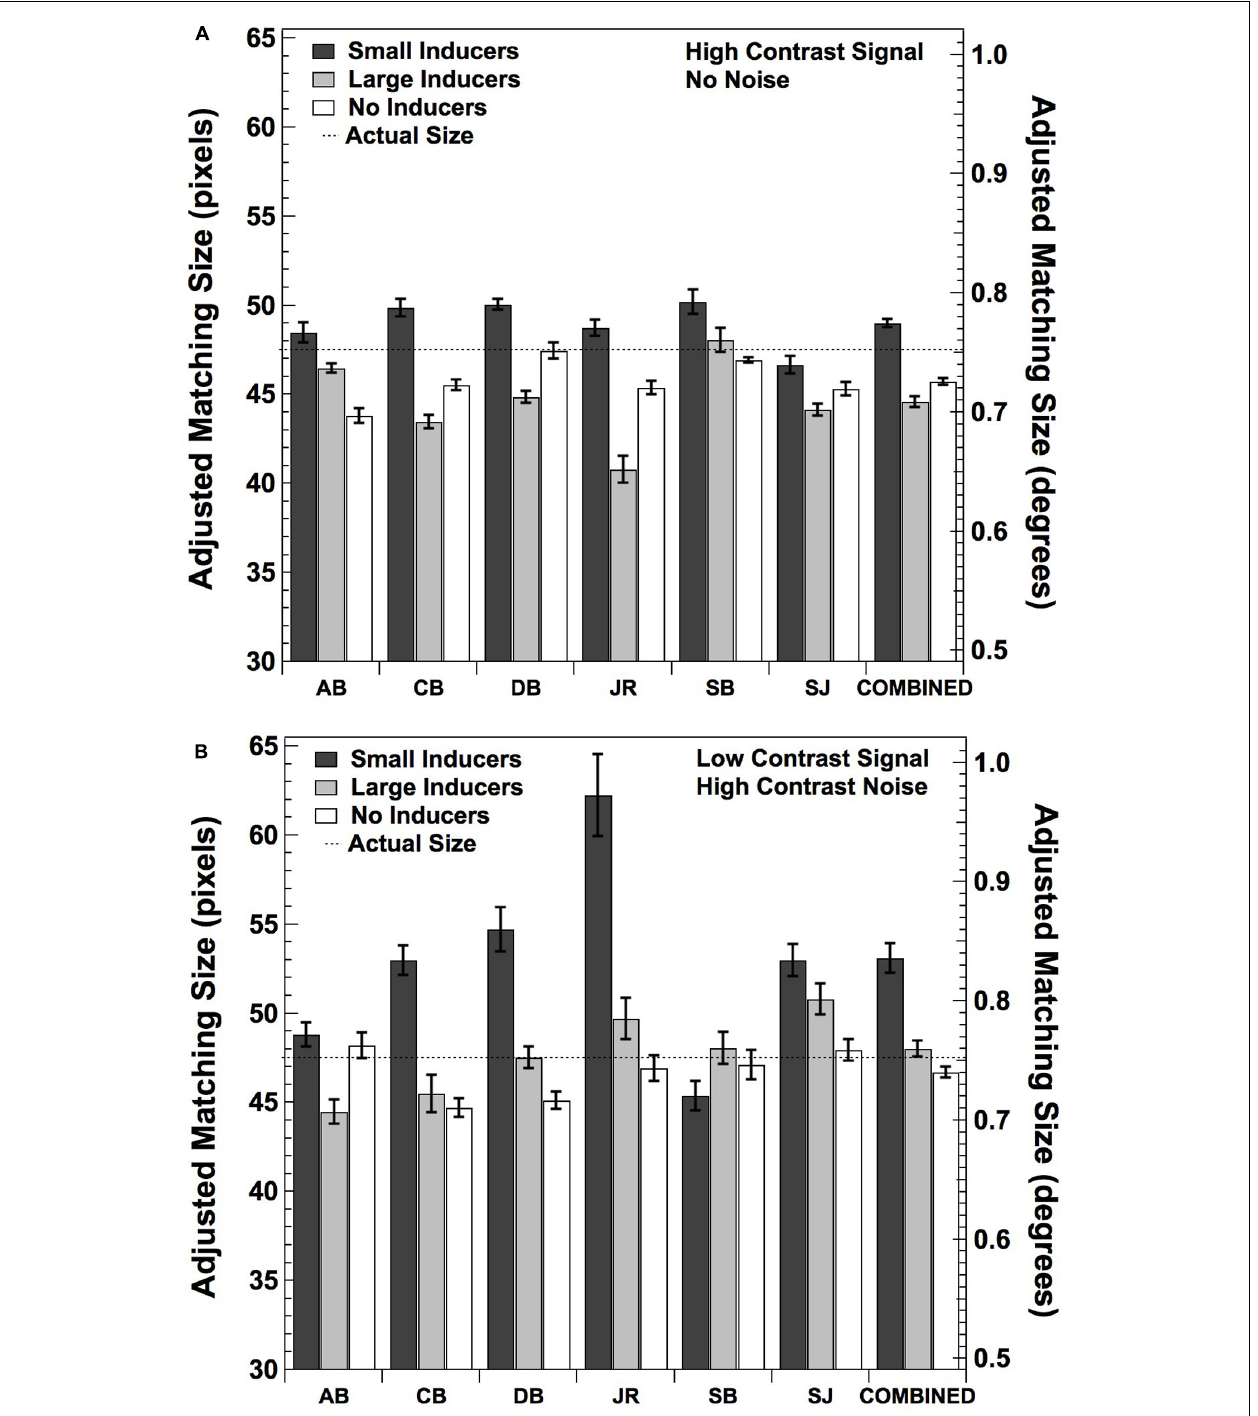
FIGURE 8 | Mean adjusted size matches for six new observers and the data combined across all observers under the same conditions as in Experiment 1 (A) and Experiment 2 (B). Error bars correspond to ± 2 standard errors of the mean.